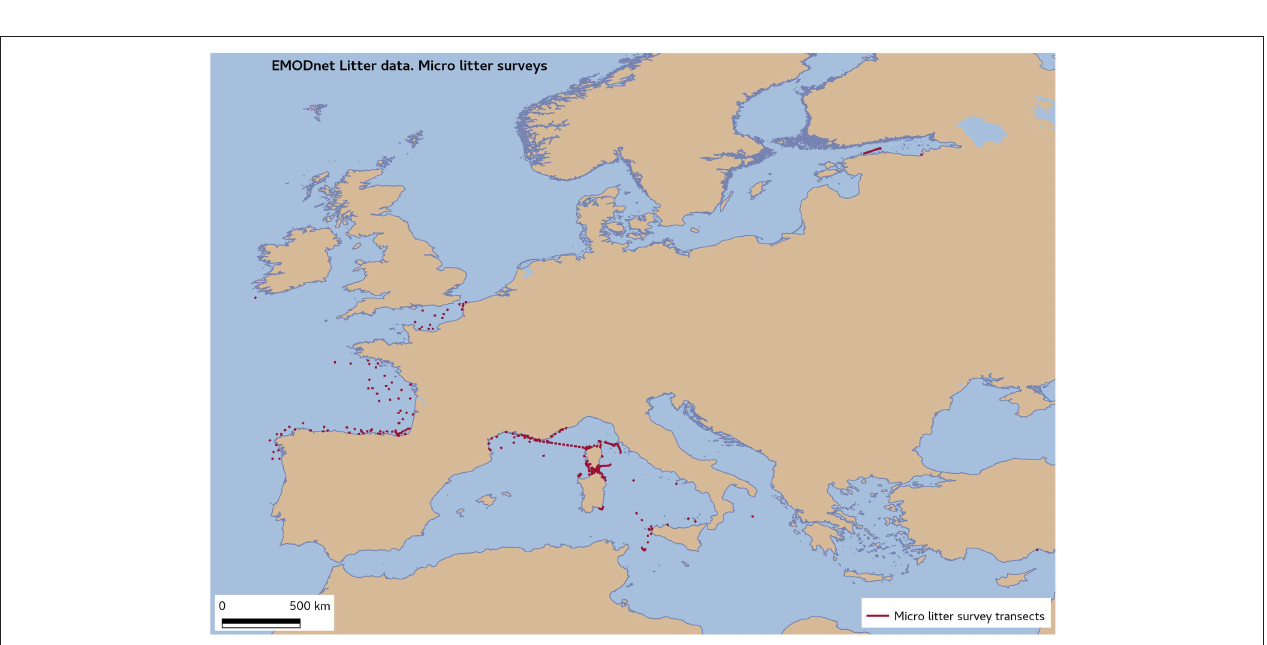
FIGURE 12 | Spatial distribution of micro-litter survey transects in EMODnet (The EMODnet Chemistry project, whose PIs are among the authors of this paper, holds the copyright on this